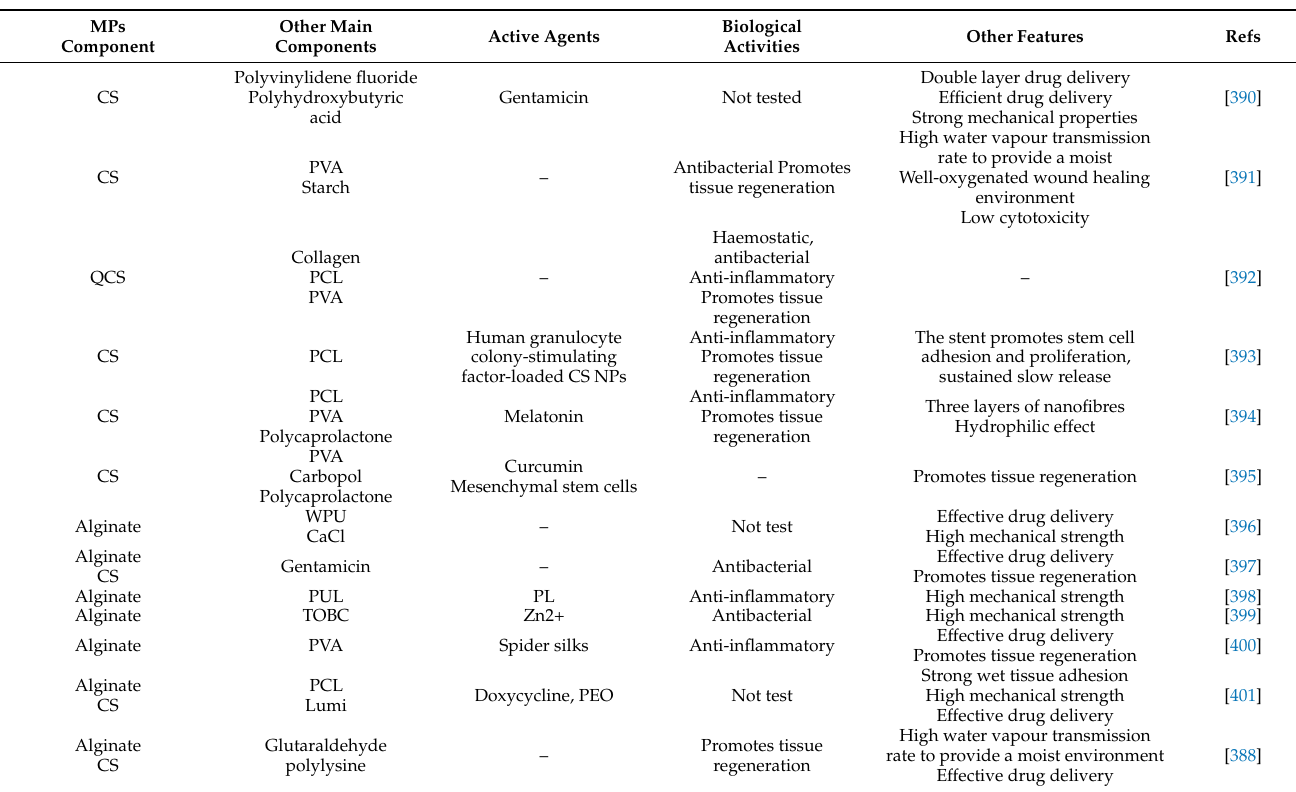
Table 8. Summary of raw materials and characteristics of MPs nanofibre dressings in recent